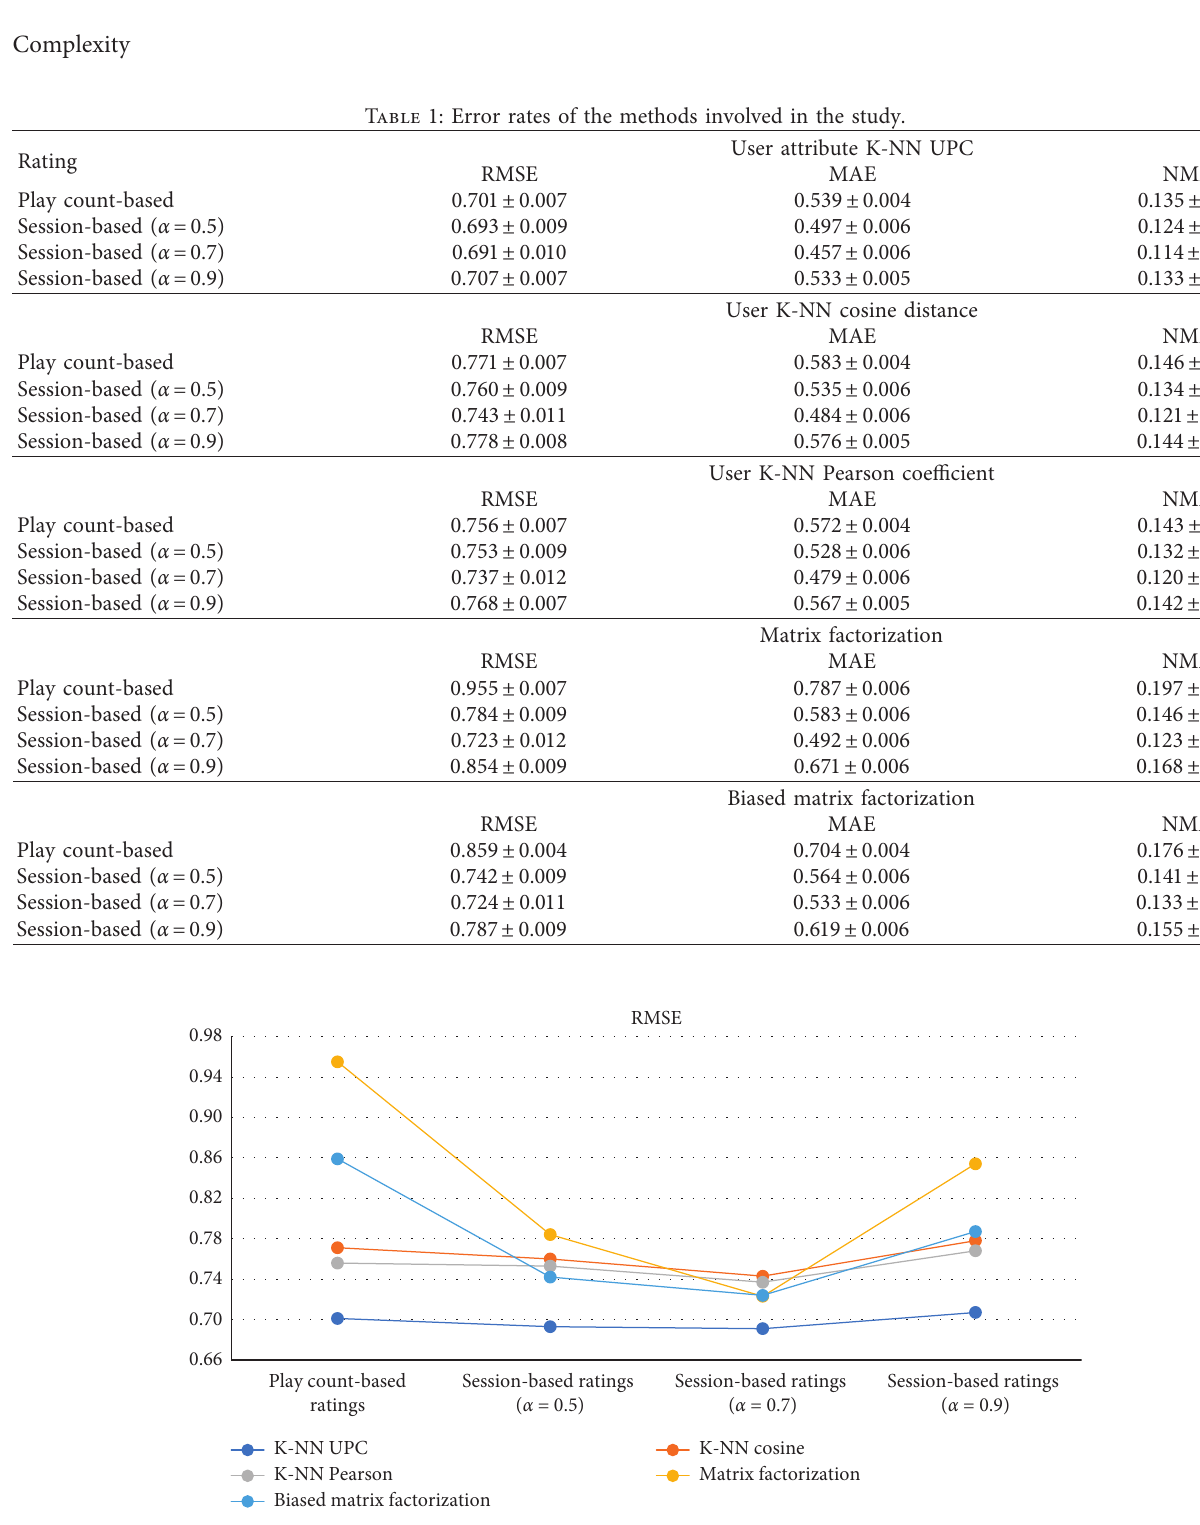
Figure 3: RMSE of the CF methods tested in the study for ratings calculated in four different